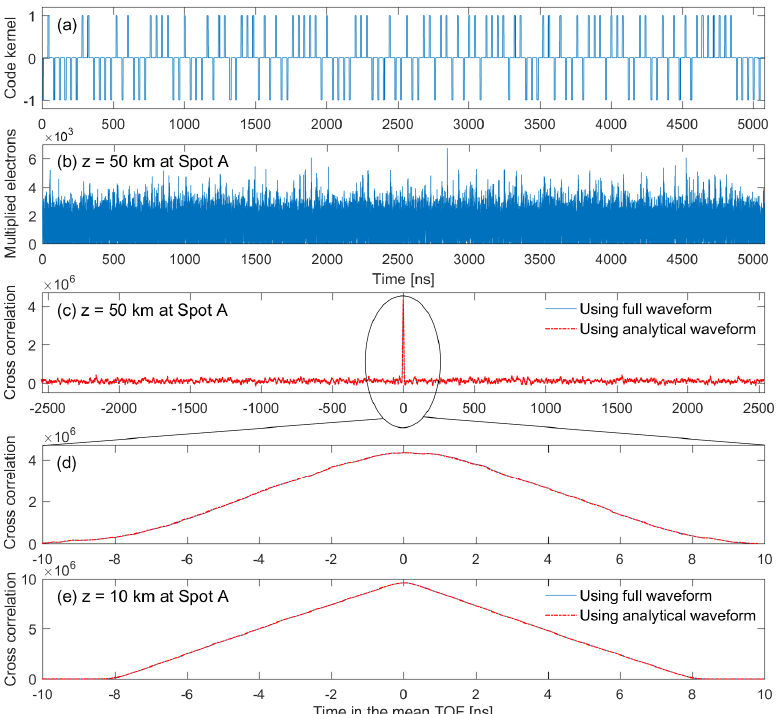
Figure 6. RZPN code kernel ( a ), received full waveform ( b ), and cross-correlations ( c – e ) using the full waveform and analytical waveform for spot A. ( d , e ) show the results of cross-correlation over a finer time scale to investigate the characteristics of the cross-correlation shape.